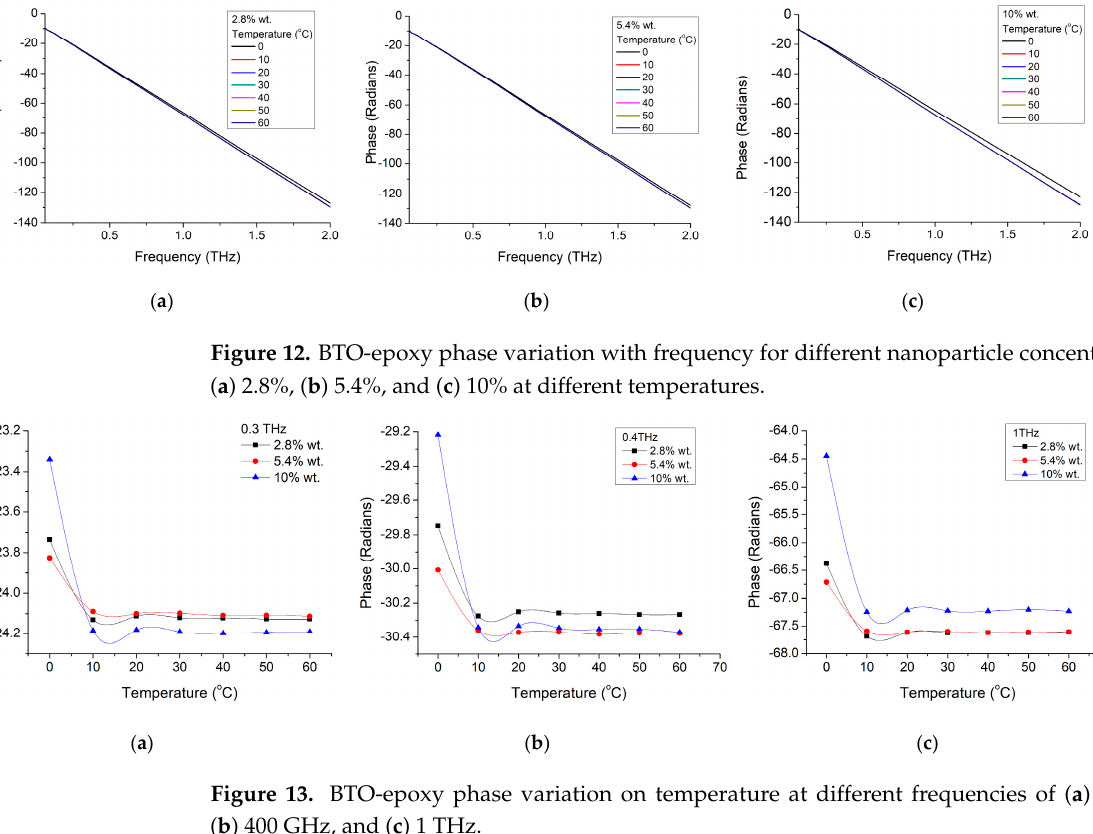
( c ) Figure 14. BTO-epoxy phase on nanoparticle volume fraction variation at different working frequencies of ( a ) 300 GHz, ( b ) 400 GHz, and ( c ) 1 THz and different temperatures. 3.2.3. SBS Nanocomposite The dielectric properties of BTO-SBS nanocomposite material with embedded BaTiO 3 into a SBS polymeric matrix, with concentrations of the filler nanoparticles of 2, 5, and 10% wt. have been further investigated and the dielectric constant and material losses variation at room temperature with the working frequency are further presented in Figure 15. As it could be seen in Figure 15a, the dielectric constant has a value quasi-independent on the working frequency at least for values above 500 GHz, but dependent on the nanoparticle concentration. Thus, while big concentrations provide dielectric constant values (~2) about five times smaller than the pure nanoparticle’s one (~10), at small nanoparticle concentrations (2% wt), the dielectric constant ε ’ is doubling its value (>4). However, it is interesting to mention that toward smaller frequencies (~200 GHz), volume fraction of 2% wt and 10% wt tends to have opposite trends but with relatively small